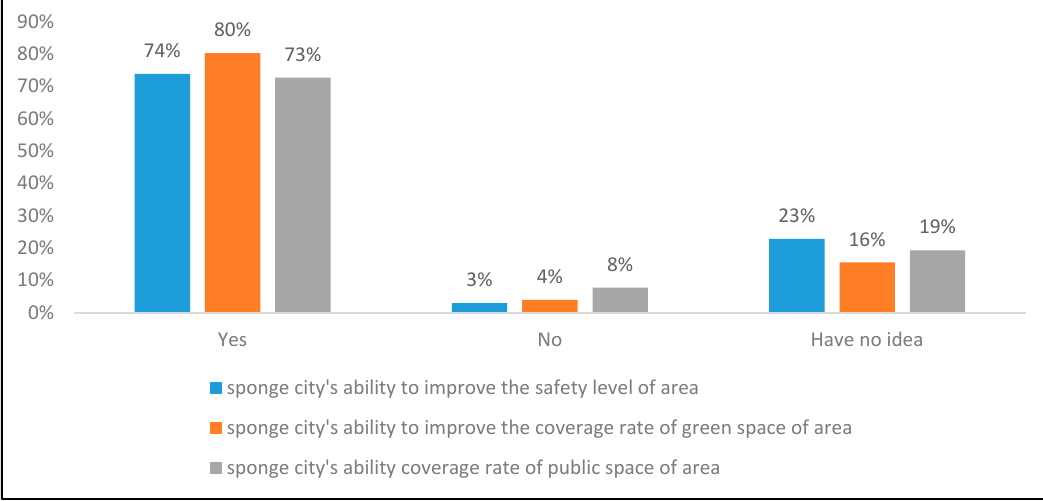
Figure 6. Residence’s perceptions of different functions of sponge city.